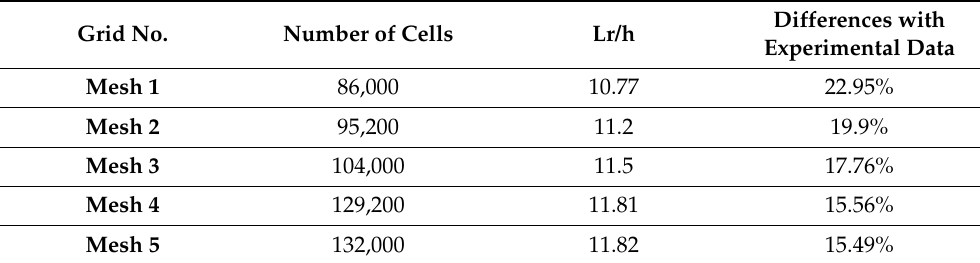
Table 1. Grid independence test results.